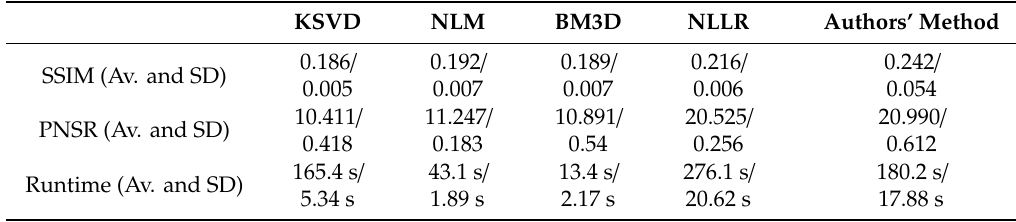
Table 6. The average (Av.) and standard deviation (SD) of